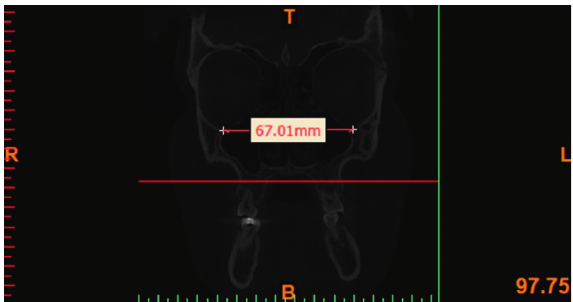
Figure 1: Reorientation of records using the Frankfurt horizontal line and the interorbital line.